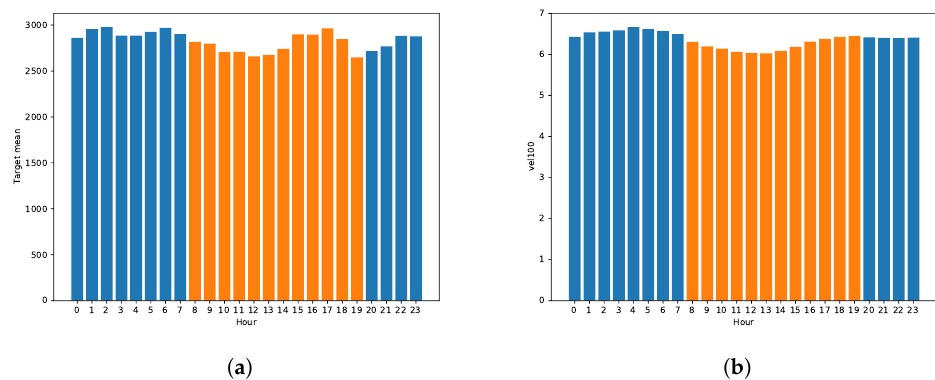
Figure 5. Histograms of wind. ( a ) Hourly mean measured in kWh of generated energy during the year 2016 in Sotavento colored by task timeOfDay. ( b ) Hourly mean of velocity in Sotavento derived from NWP data for the year 2016 and measured in m/s at 100m colored by task timeOfDay.